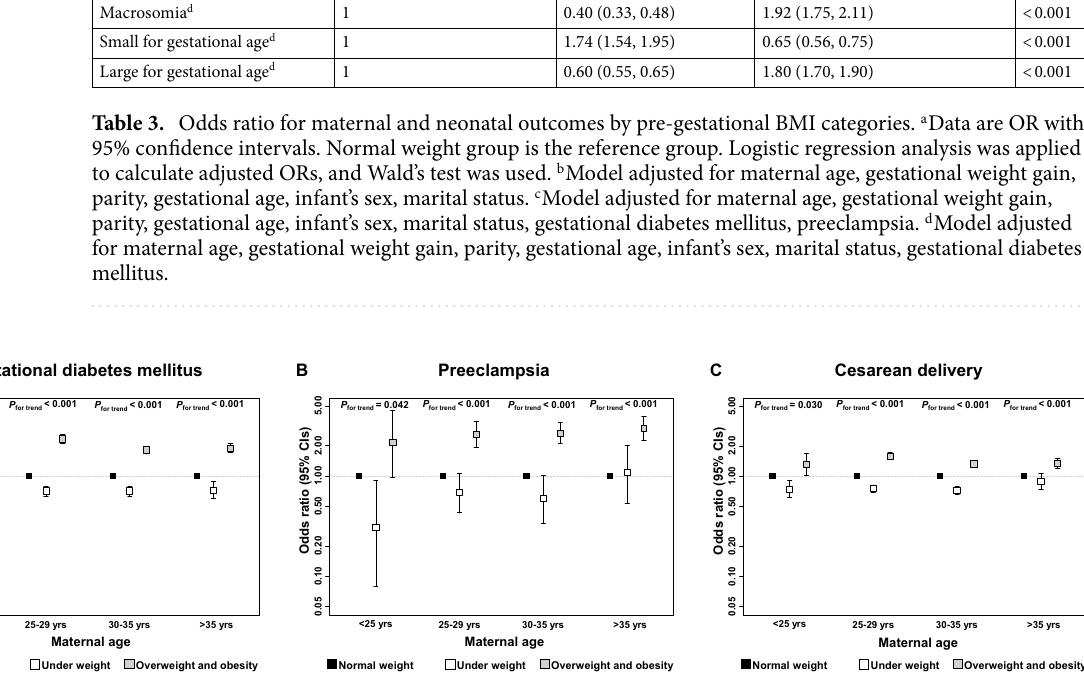
Figure 1. Pre-gestational BMI and risks of maternal pregnancy outcomes stratified by maternal age. Figures ( A – C ) show the age specific odds ratio and 95% CI for pre-pregnancy BMI on maternal outcomes. Models were adjusted for maternal age, gestational weight gain, parity, gestational age, infant’s sex and marital status, and models in ( C ) were additional adjusted for GDM and